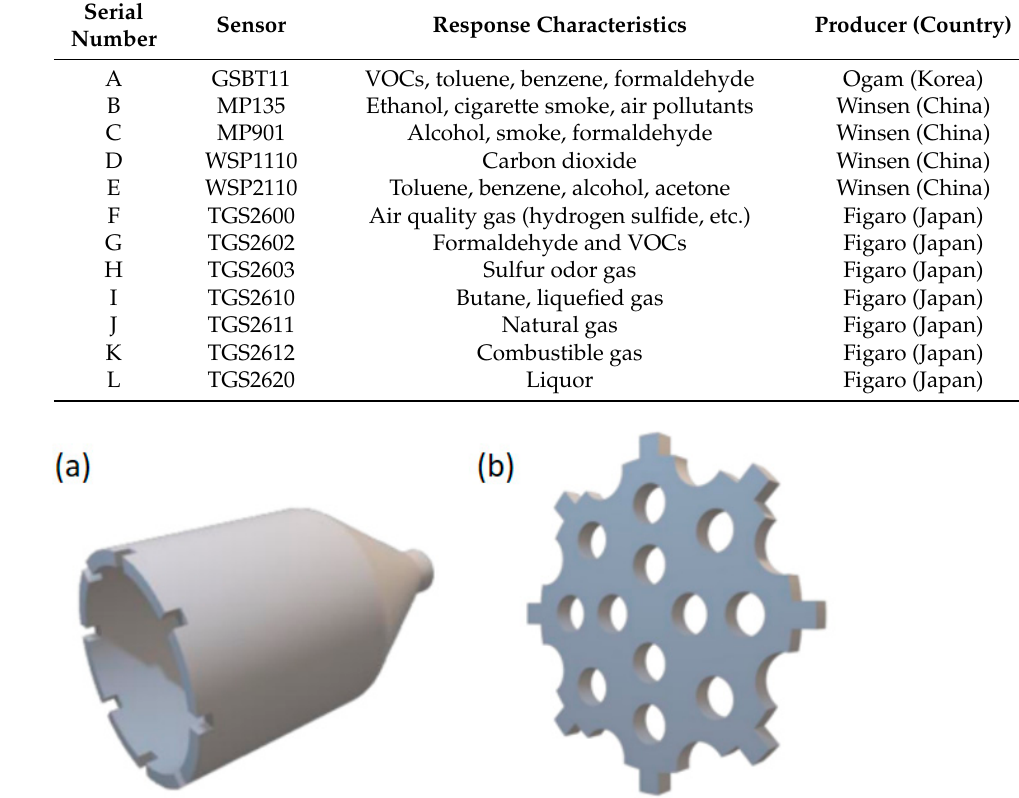
Figure 1. 3D schematic diagram of sensor cavity structure. ( a ) The schematic diagram of external cavity column. ( b ) The schematic diagram of octagonal plate.